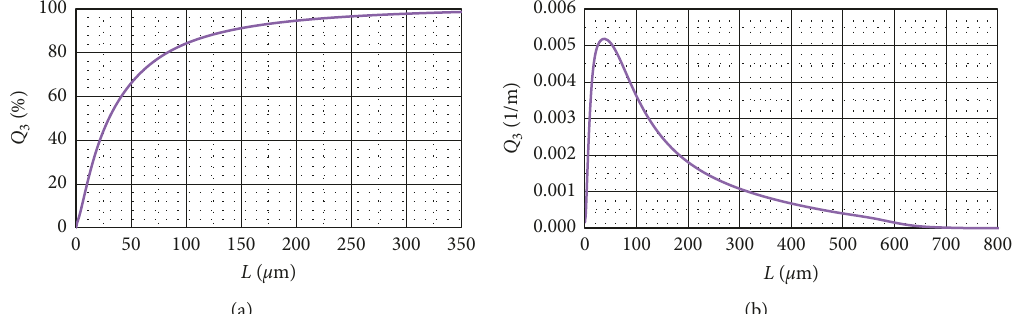
Figure 8: Particle distributions obtained by the use of a pipe for Re